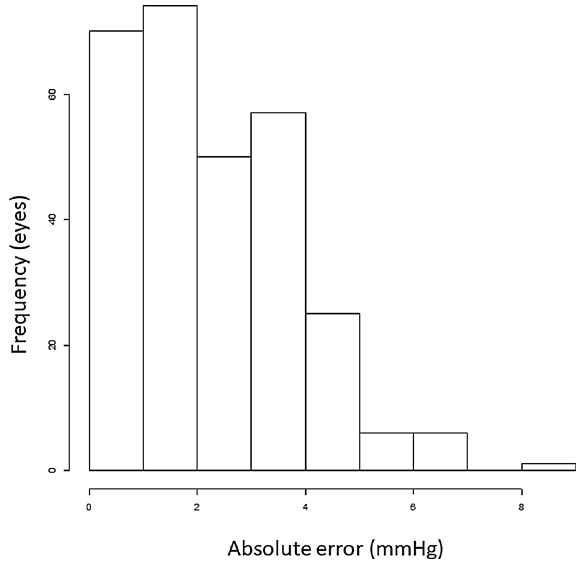
Figure 3. Histogram of absolute prediction error associated with MLM model. MLM multivariate linear